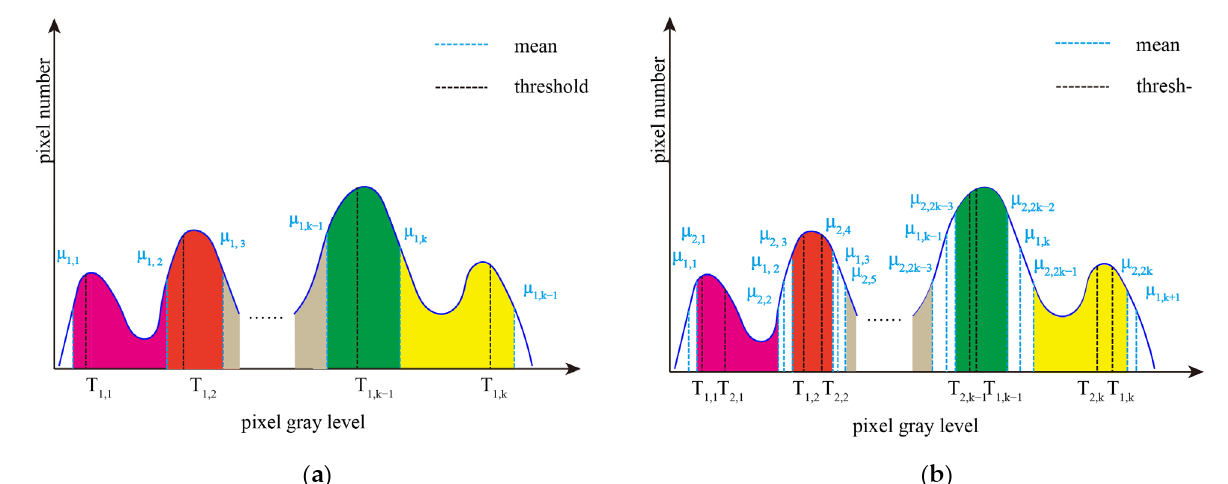
Figure 3. An example of interval iteration at different stages. ( a ) Grayscale interval, and ( b ) Updated grayscale interval after interval iteration.